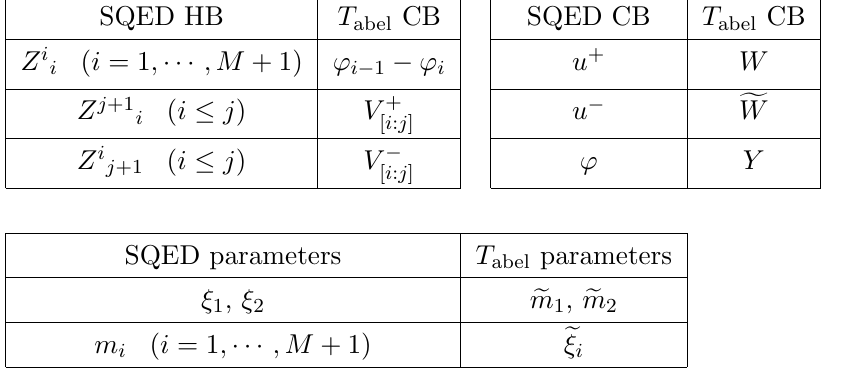
m 1 and ’ M +1 (cid:17) m 2 e e